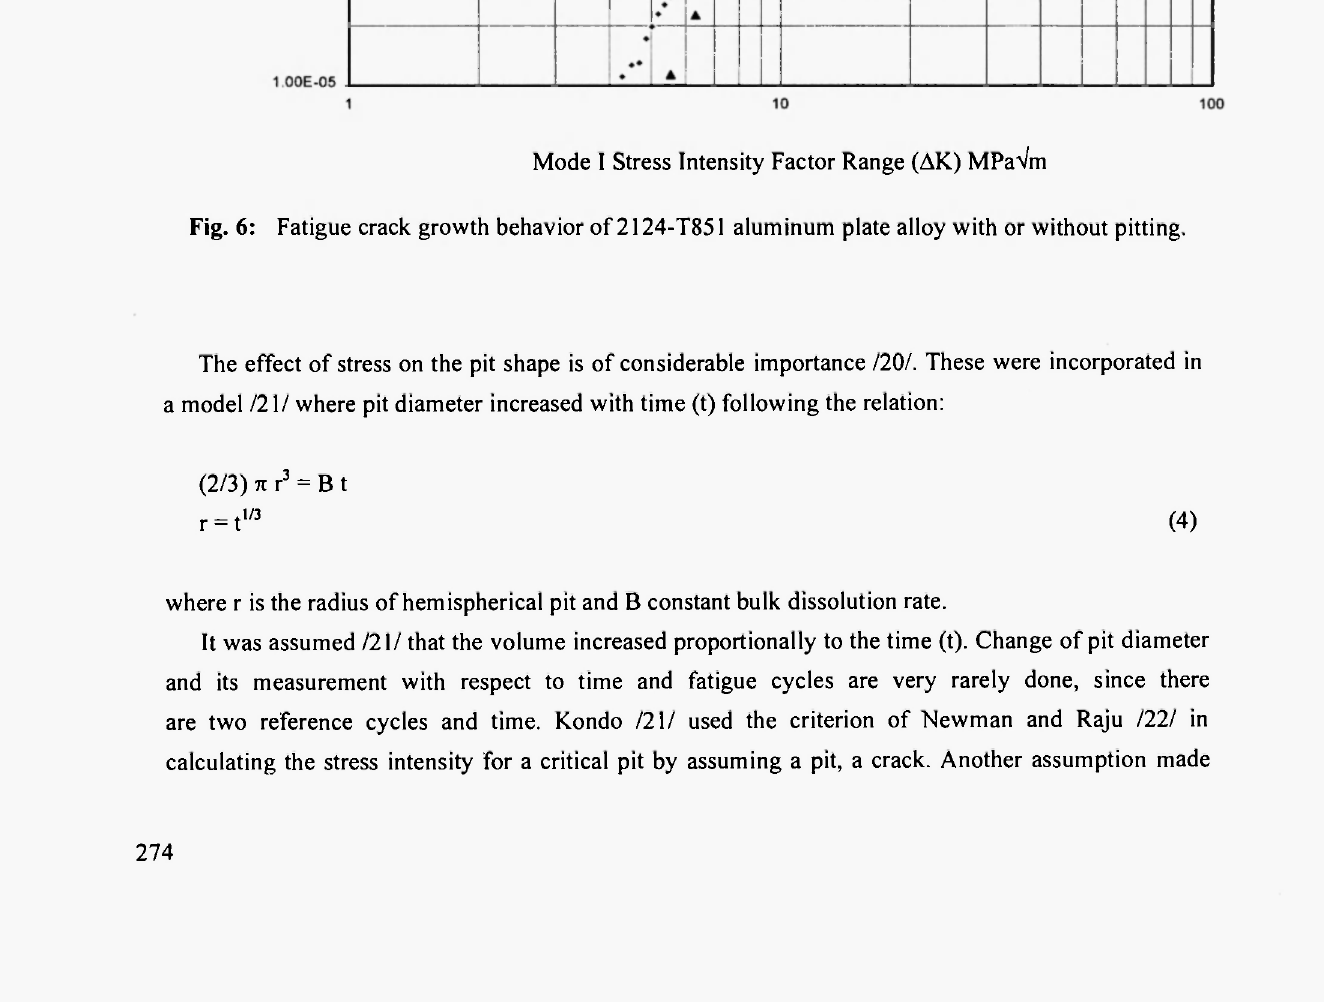
Fig. 6: Fatigue crack growth behavior of 2124-T851 aluminum plate alloy with or without